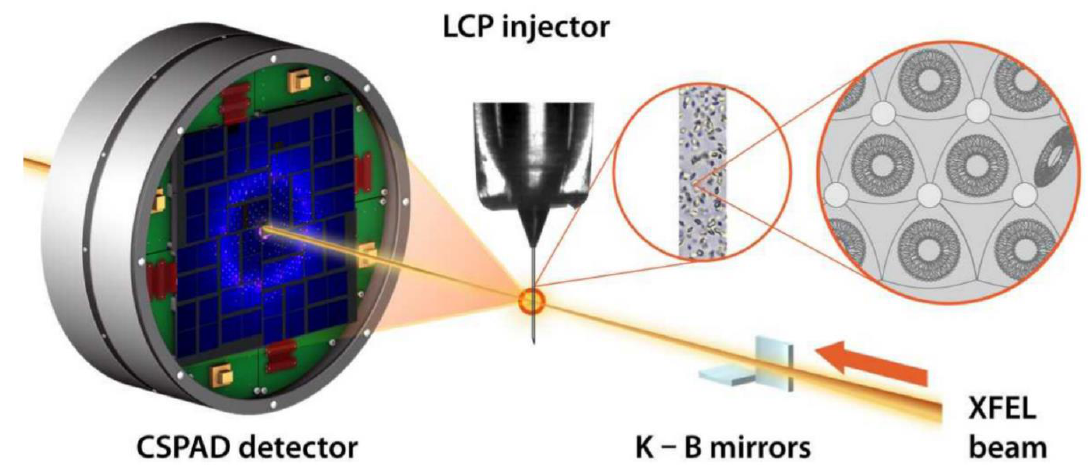
Figure 1. Experimental setup for serial femtosecond crystallography (SFX) data collection using an LCP injector. Microcrystals dispersed in LCP are injected as a continuous column of 20–50 μm diameter and intersected with 1.5 μm diameter pulsed XFEL beam focused by Kirkpatrick–Baez (KB) mirrors. Single pulse diffraction patterns are collected at 120 Hz using a CSPAD detector. (Adapted from Liu et al. [28]).